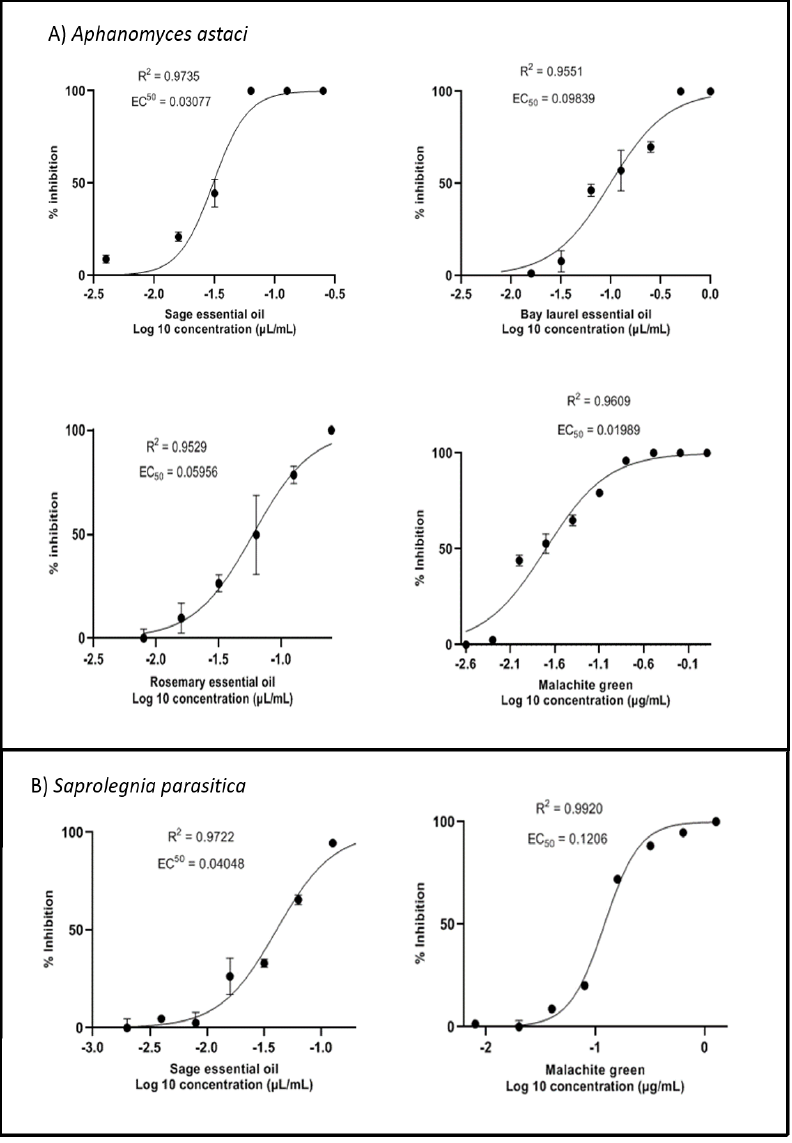
Figure 2. Mycelial growth inhibition curves of A. astaci and S. parasitica treated with sage, bay laurel, and rosemary essen- tial oils. Non-linear regression curve fitting to estimate EC 50 values (i.e., concentrations of samples at which mycelial laurel, and rosemary essential oils. Non-linear regression curve fitting to estimate EC 50 values (i.e., growth was inhibited by 50%) for S. parasitica treated with rosemary and bay laurel essential oils could not be performed, since 100% inhibition was not achieved even with the highest tested concentrations. Mean values ± standard error (n = 3) are presented.